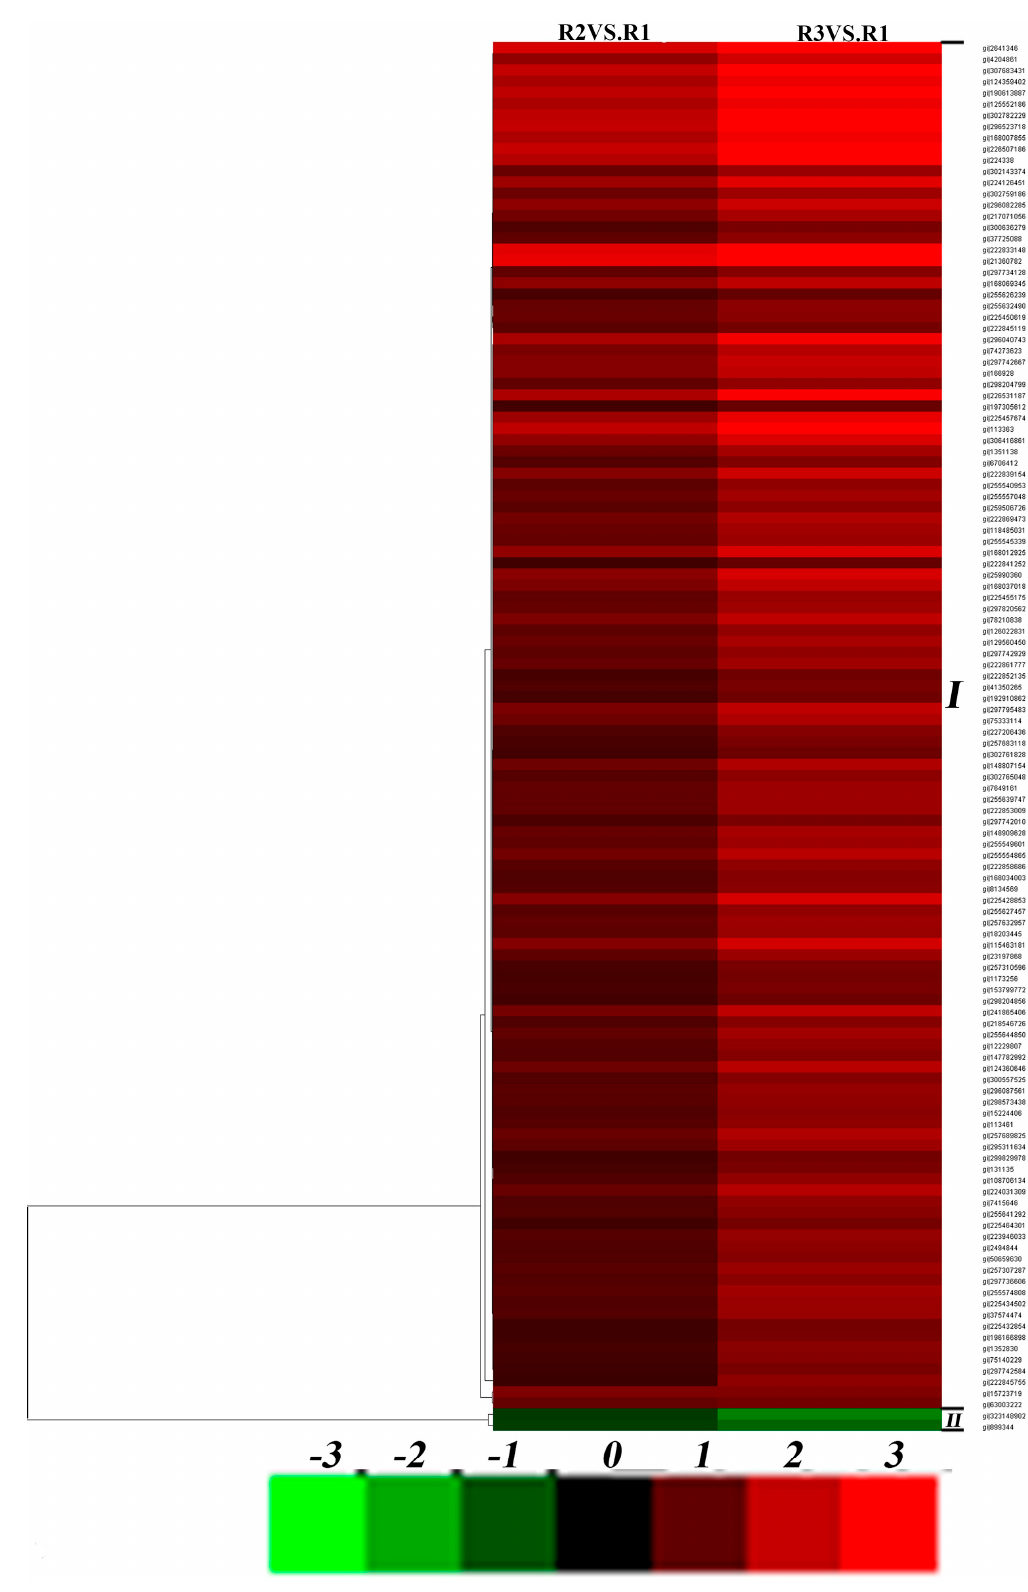
Figure 6. Hierarchical display of data from differentially expressed protein of roots under drought stresses. Upregulated proteins are in red; downregulated proteins are in green (for interpretation of the color references in the figure legend).